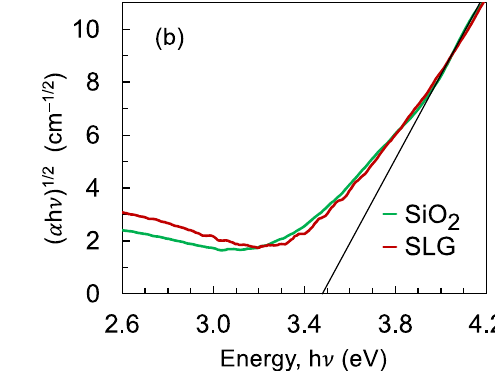
Figure 1. GIXRD spectra of TiO 2 films deposited on Si, SiO 2 , and SLG substrates with a film thickness of 80 nm.